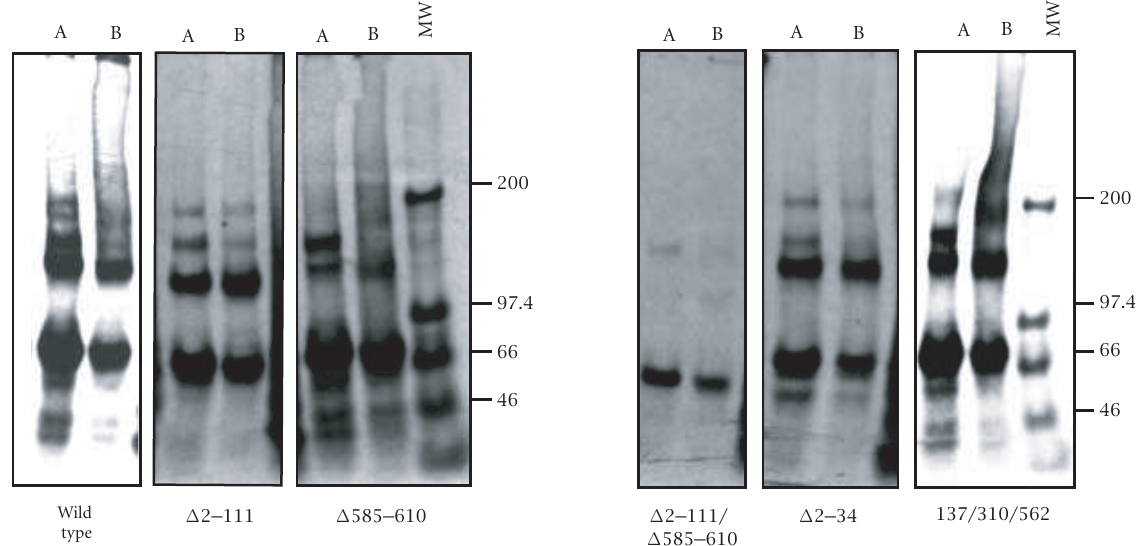
Figure 3: In vitro synthesized pORF 2 and mutant proteins were subjected to immunoprecipitation before (A) or after (B) cross-linking. The mixtures were analyzed on a nonreducing 7 . 5 % polyacrylamide gel. Molecular size markers are shown in kilodaltons (MW).